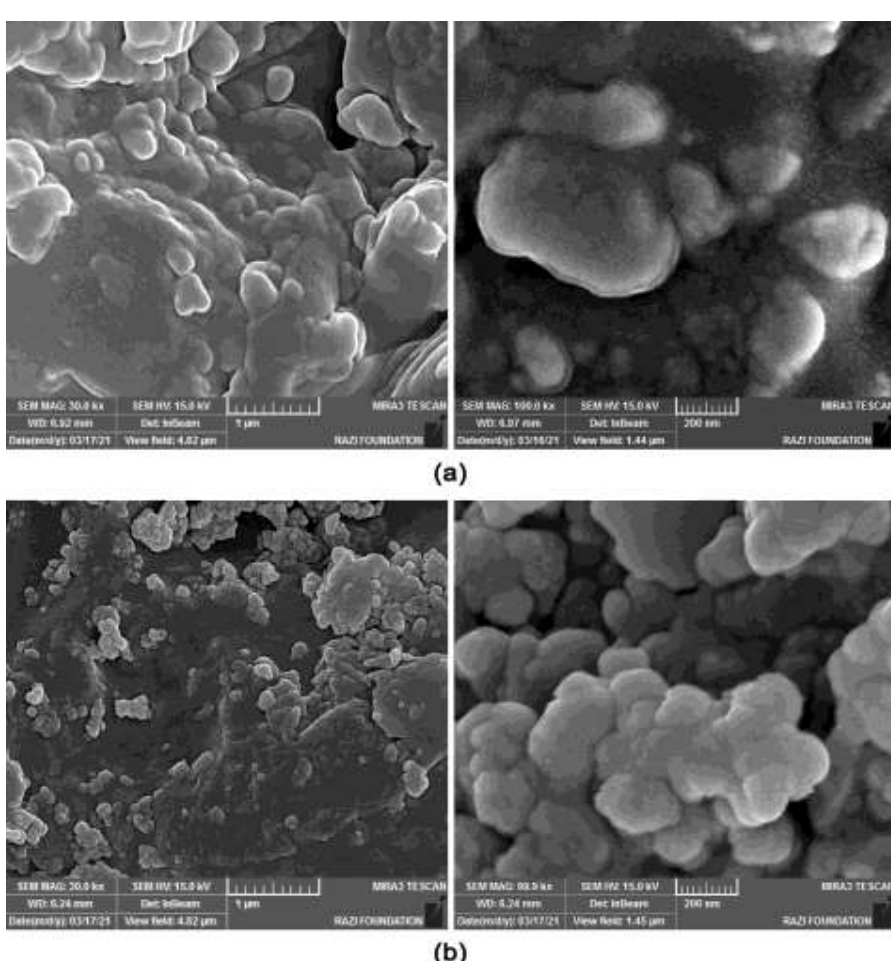
Figure 9: SEM image of PS with (a) 1% Al 2 O 3 and (b) 4% Al 2 O 3